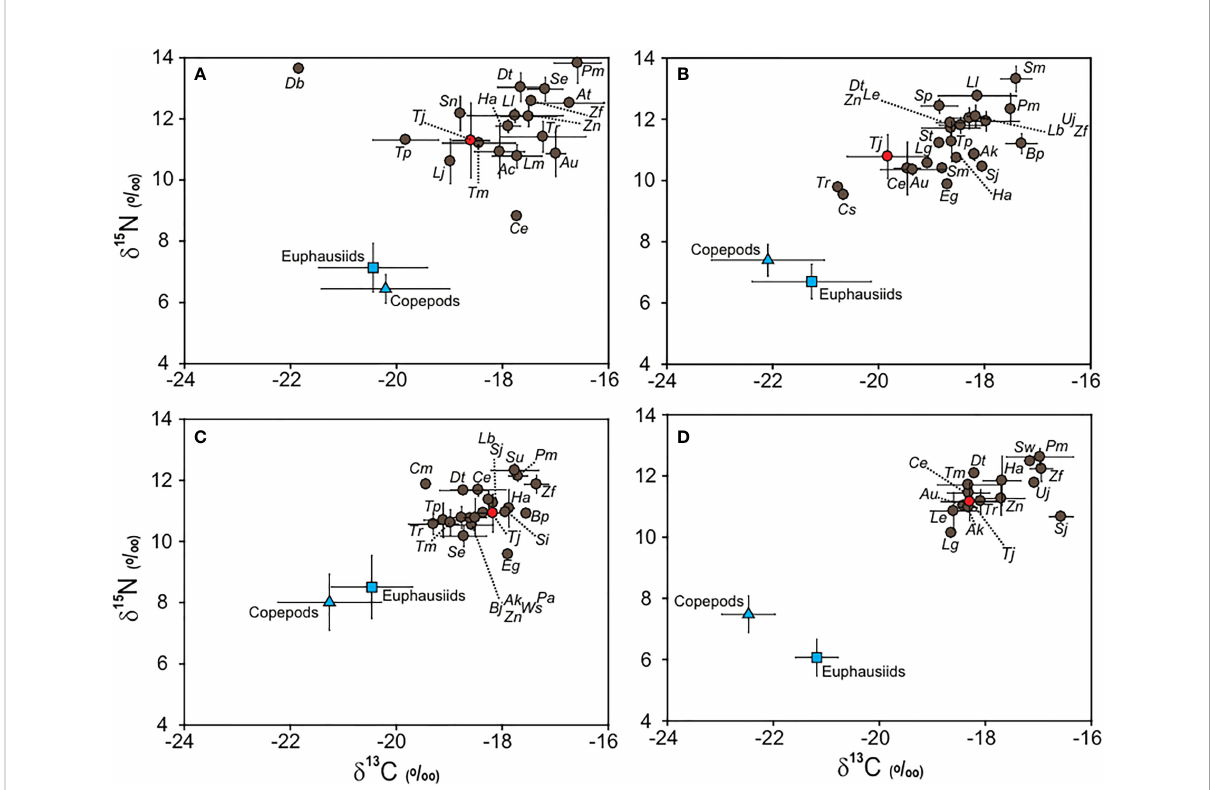
FIGURE 5 Bi-plots of d 13 C and d 15 N values of zooplankton (blue squares, euphausiids; blue triangles, copepods), large-head hairtail (red circles, Trichiurus japonicus ), and other fi shes (gray circles) in the South Sea of Korea during February (A) , May (B) , August (C) , and November (D) 2021. Values are presented as mean d 13 C and d 15 N ( ‰ ± 1 SD). Species codes are presented in Table 3